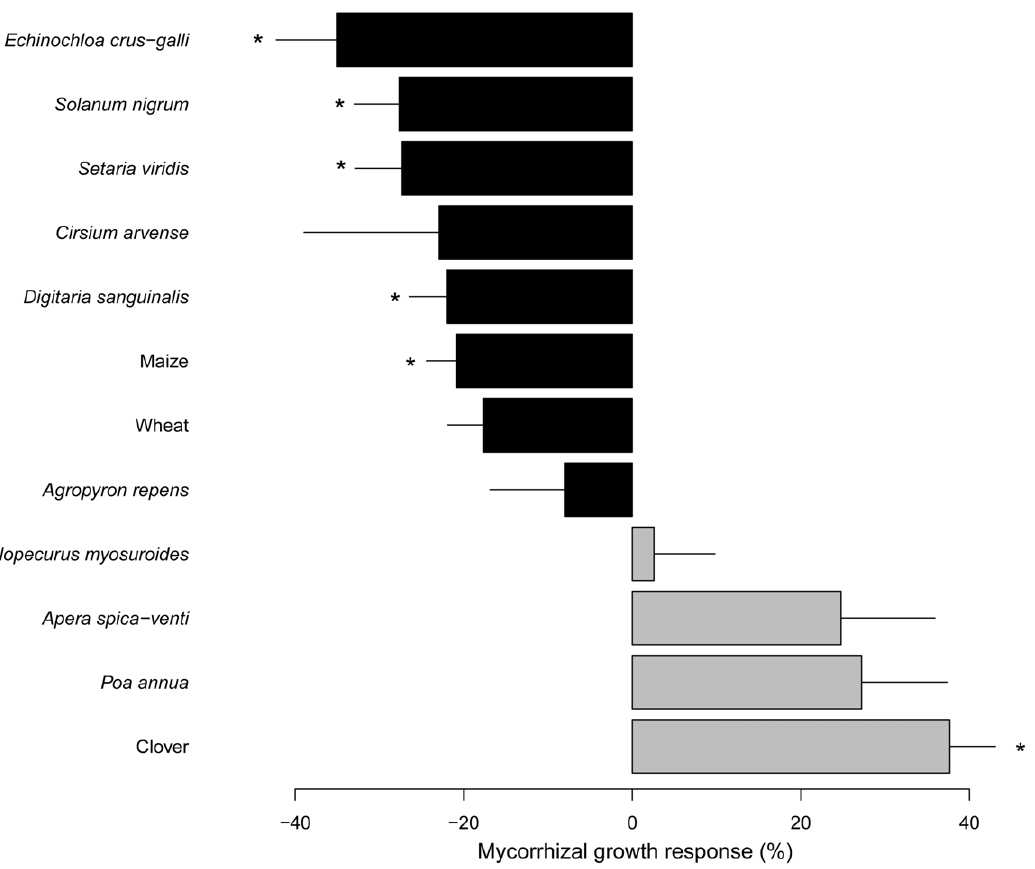
Figure 1. Mycorrhizal growth responses (%) of the nine weed and three crop species in experiment 1. Bars are means of six replicates 6 SEM. Bars in grey indicate species with a total root length colonized by G. intraradices , 50% while bars in black indicate species with total root length colonized by G. intraradices . 50%. Asterisks represent significant differences ( P , 0.05) in total biomass between the AMF treatment and NM control, for each